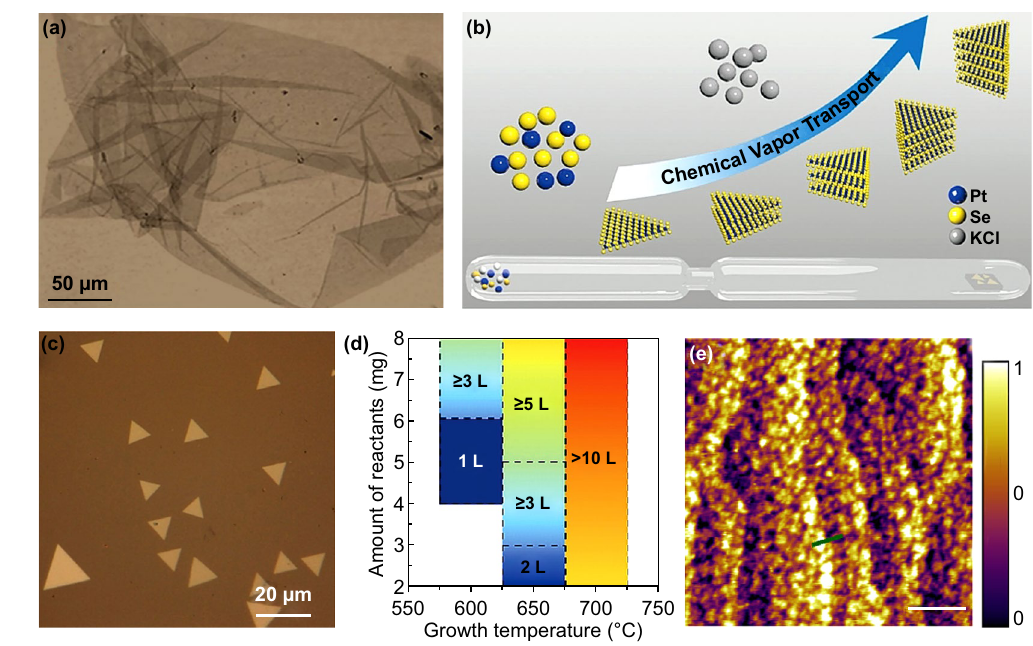
Fig. 9 2D PtSe 2 prepared by solution process/CVT/MBE. a Optical image of the PtSe 2 nanosheets prepared via an aqueous‑phase reaction process. Reproduced with permission [135]. Copyright 2017, American Chemical Society. b Schematic diagram of the controlled synthesis of PtSe 2 by CVT. c Optical image of PtSe 2 triangle nanoflakes prepared by CVT. d Relationship of the layer numbers of the as‑grown PtSe 2 trian‑ gle nanoflakes as a function of growth temperature and amount of reactants. Reproduced with permission [142]. Copyright 2019, John Wiley and Sons. e AFM image of the PtSe 2 grown on the bilayer graphene by MBE method. Reproduced with permission [43]. Copyright 2017, IOP Publishing